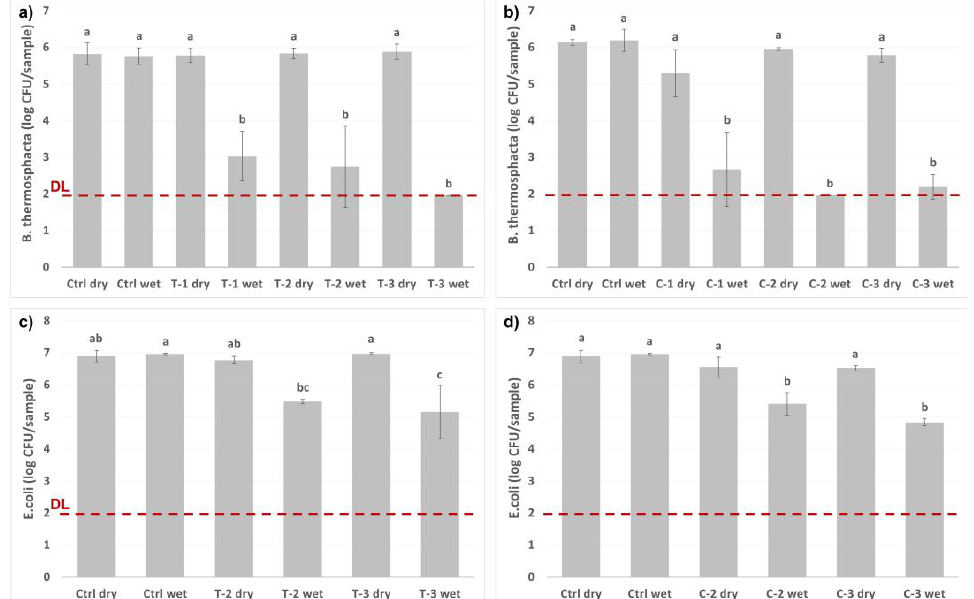
Figure 7. Antimicrobial activity of thymol (T) and carvacrol (C) loaded nanocarriers on Brochothrix thermosphacta ( a , b ) and Escherichia coli ( c , d ). Two controls were included: “dry” (empty glass vial) and “wet” (1 mL buffer solution). Two or three different amounts of particles were tested on the bacteria: (1) 4 mg, (2) 8 mg, and (3) 12 mg, either as dry or with the addition of 1 mL buffer solution. The bacteria were incubated at 20 °C for 1 h. One-way analysis of variance (ANOVA), followed by the Tukey test, was performed to analyze the significant differences between the samples. The different letters (a–c) represent the Tukey groups. Samples which do not share the same letter are significantly different ( p < 0.05). The red line presents the detection limit (DL).